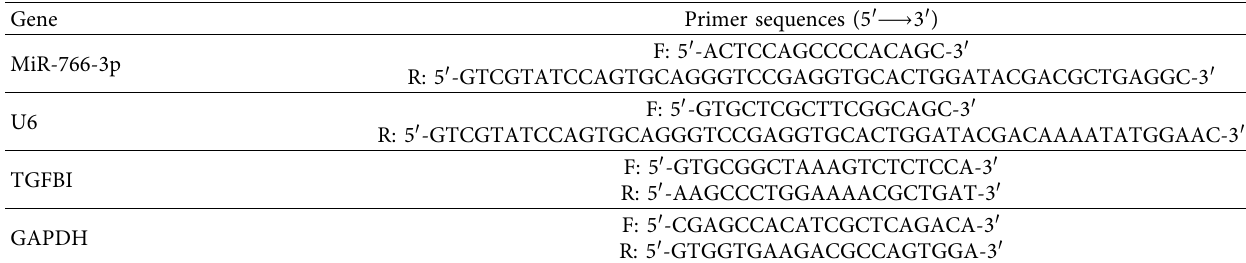
Table 1: Information of primer